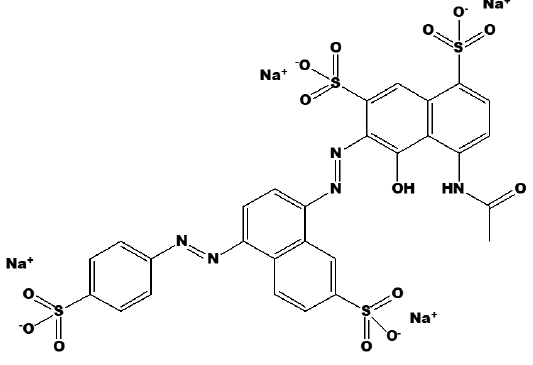
Figure 5. Chemical structure of Brilliant Black BN.